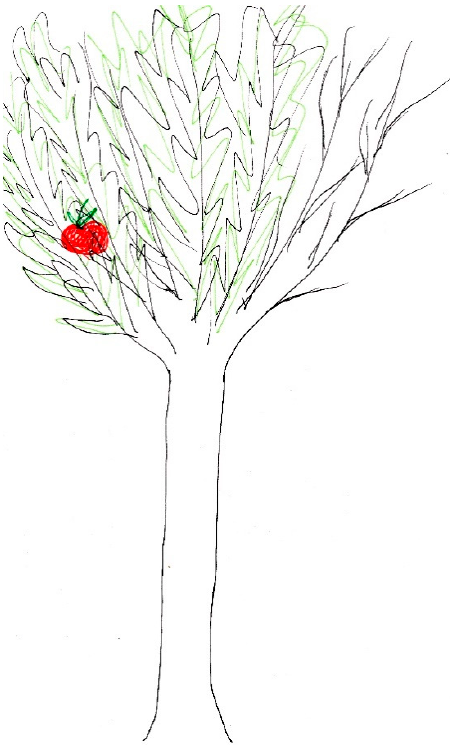
Figure 1. Sophia’s Figure 1. Sophia’s drawing.